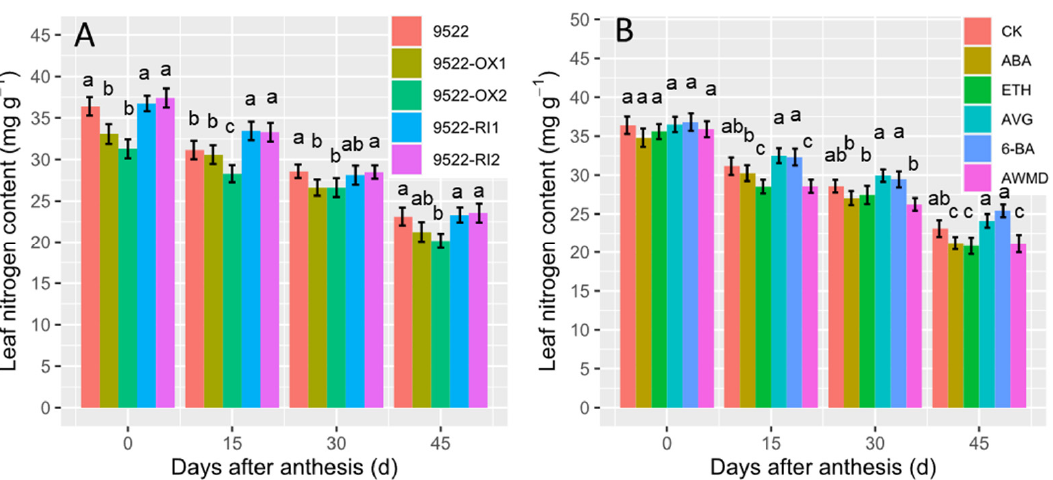
Figure 3. Changes in flag leaf nitrogen contents of wildtype and transgenic lines ( A ), and application of exogenous phytohormone/alternate wetting and under moderate drying (AWMD) irrigation ( B ) during grain filling (0–45 days after anthesis). Symbols and significance levels are as described in Figure 1.